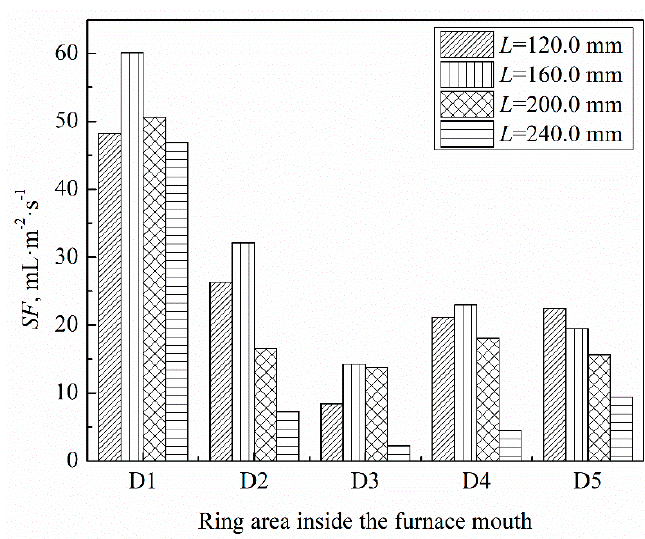
Figure 8. SF at the different ring areas inside the furnace mouth ( Q = 36.4 Nm 3 ·h − 1 ).